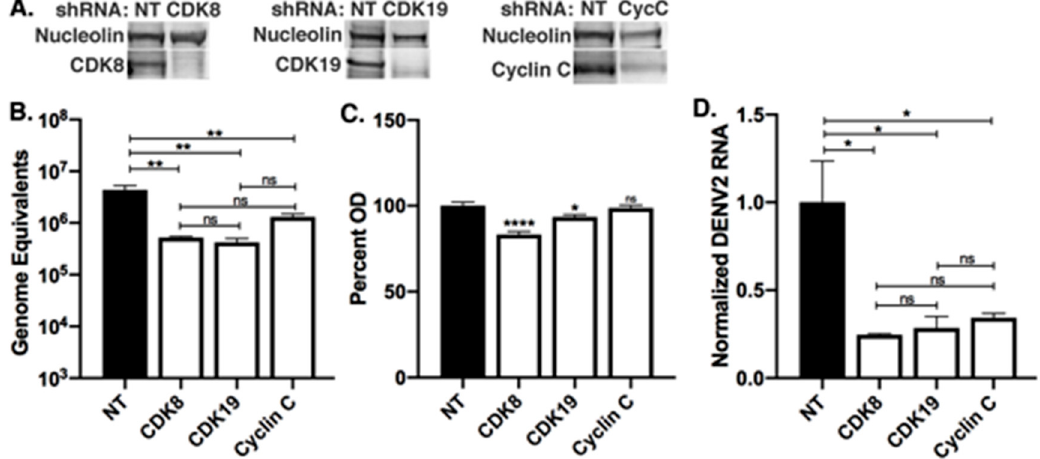
Figure 2. Knockdowns of CDK8 and CDK19 reduce DENV2 replication. ( A ) Western blot analysis of 10 µg of total protein from nuclear extracts of Huh7 cells transduced at an MOI of 1 with lentivirus-mediated non-target control or CDK8-targeted shRNA, CDK19-targeted shRNA, or cyclin C-targeted shRNA. ( B ) Lentivirus-transduced Huh7 cells were infected with DENV2 at MOI 1 for 24 h, and total cellular RNA analyzed by qRT-PCR for DENV RNA quantification relative to in vitro transcribed DENV genome equivalent (GE) standard curve ( n = 3 biological replicates per group; ** p < 0.01; one-way ANOVA with Tukey’s multiple comparisons test. Error bars represent mean +/ SEM). ( C ) Relative optical density read in lentivirus-transduced Huh7 cells after four days of selection, then treated with CellTiter 96 Aqueous One Solution. ( n = 4 biological replicates. * p < 0.05, **** p < 0.0001; one-way ANOVA with Dunnett’s test. Error bars represent mean +/ SEM). ( D ) Lentivirus-transduced Huh7 cells were infected with DENV2 at MOI 1 for 24 h, and total cellular RNA analyzed by qRT-PCR for DENV RNA quantification normalized to the housekeeping gene, SDHA , and relative to expression in non-target controls ( n = 3 biological replicates per group; * p < 0.05, one-way ANOVA with Tukey’s multiple comparisons test. Error bars represent mean +/ SEM).